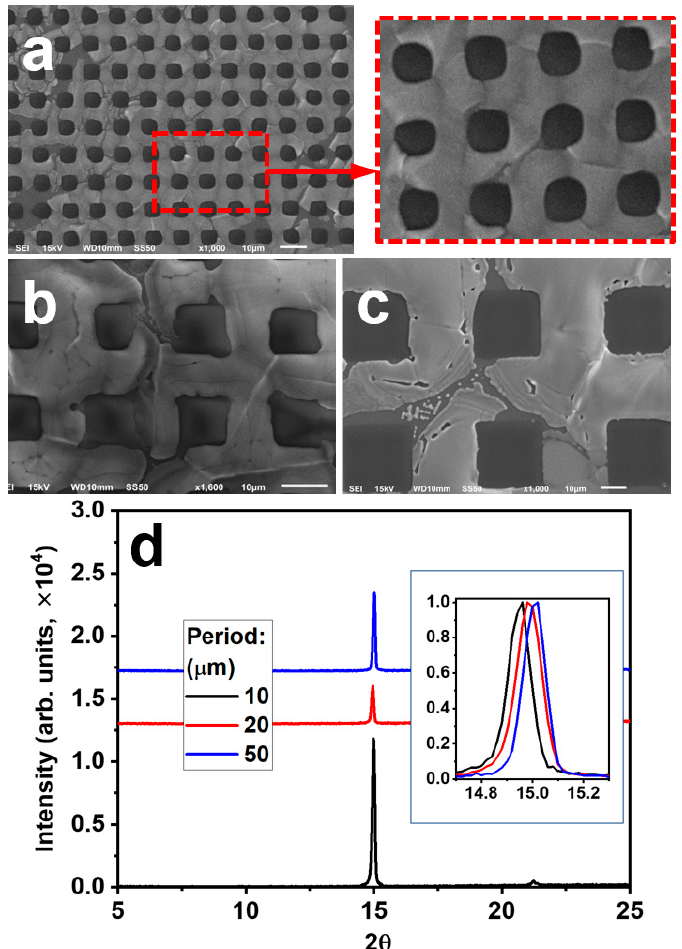
Figure 3. ( a ) SEM image for the patterned structure with a period of 10 μ m and an enlarged view of a local area. ( b , c ) SEM images for the structures with a patterning period of 20 and 50 μ m, respectively. ( d ) XRD spectra measured on the three kinds of structures patterned at different periods. Inset: an enlarged view of the spectra.